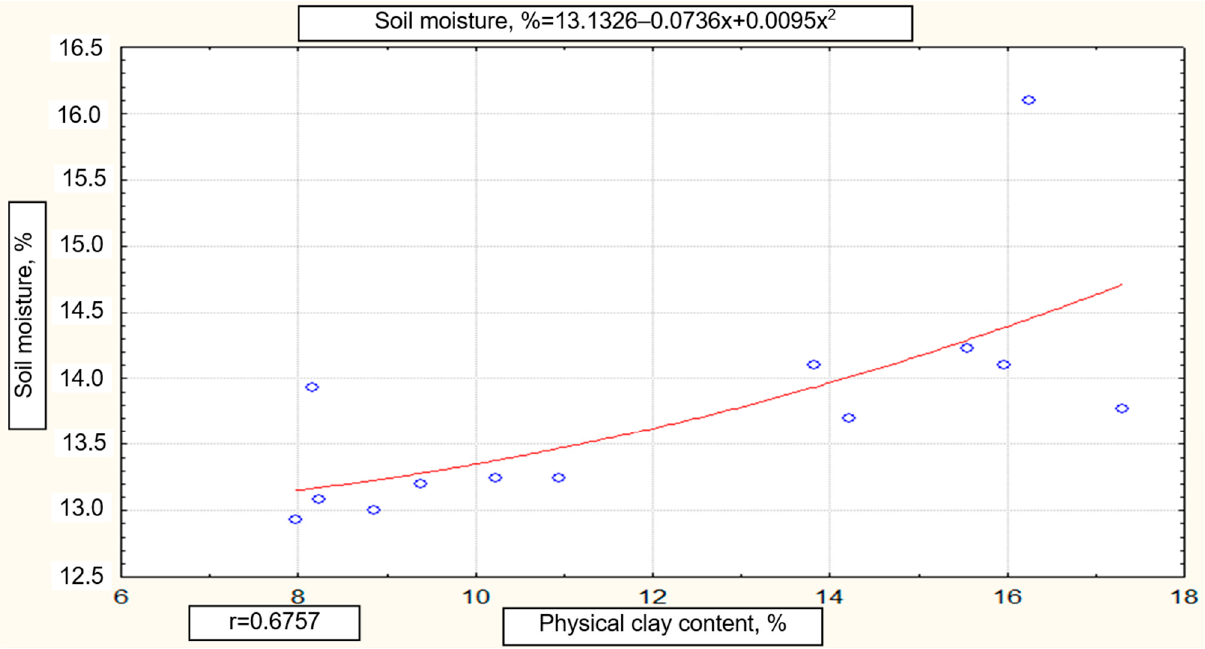
Figure 4. The relationship between soil moisture and the physical content of clay. Source: authors’ research results.